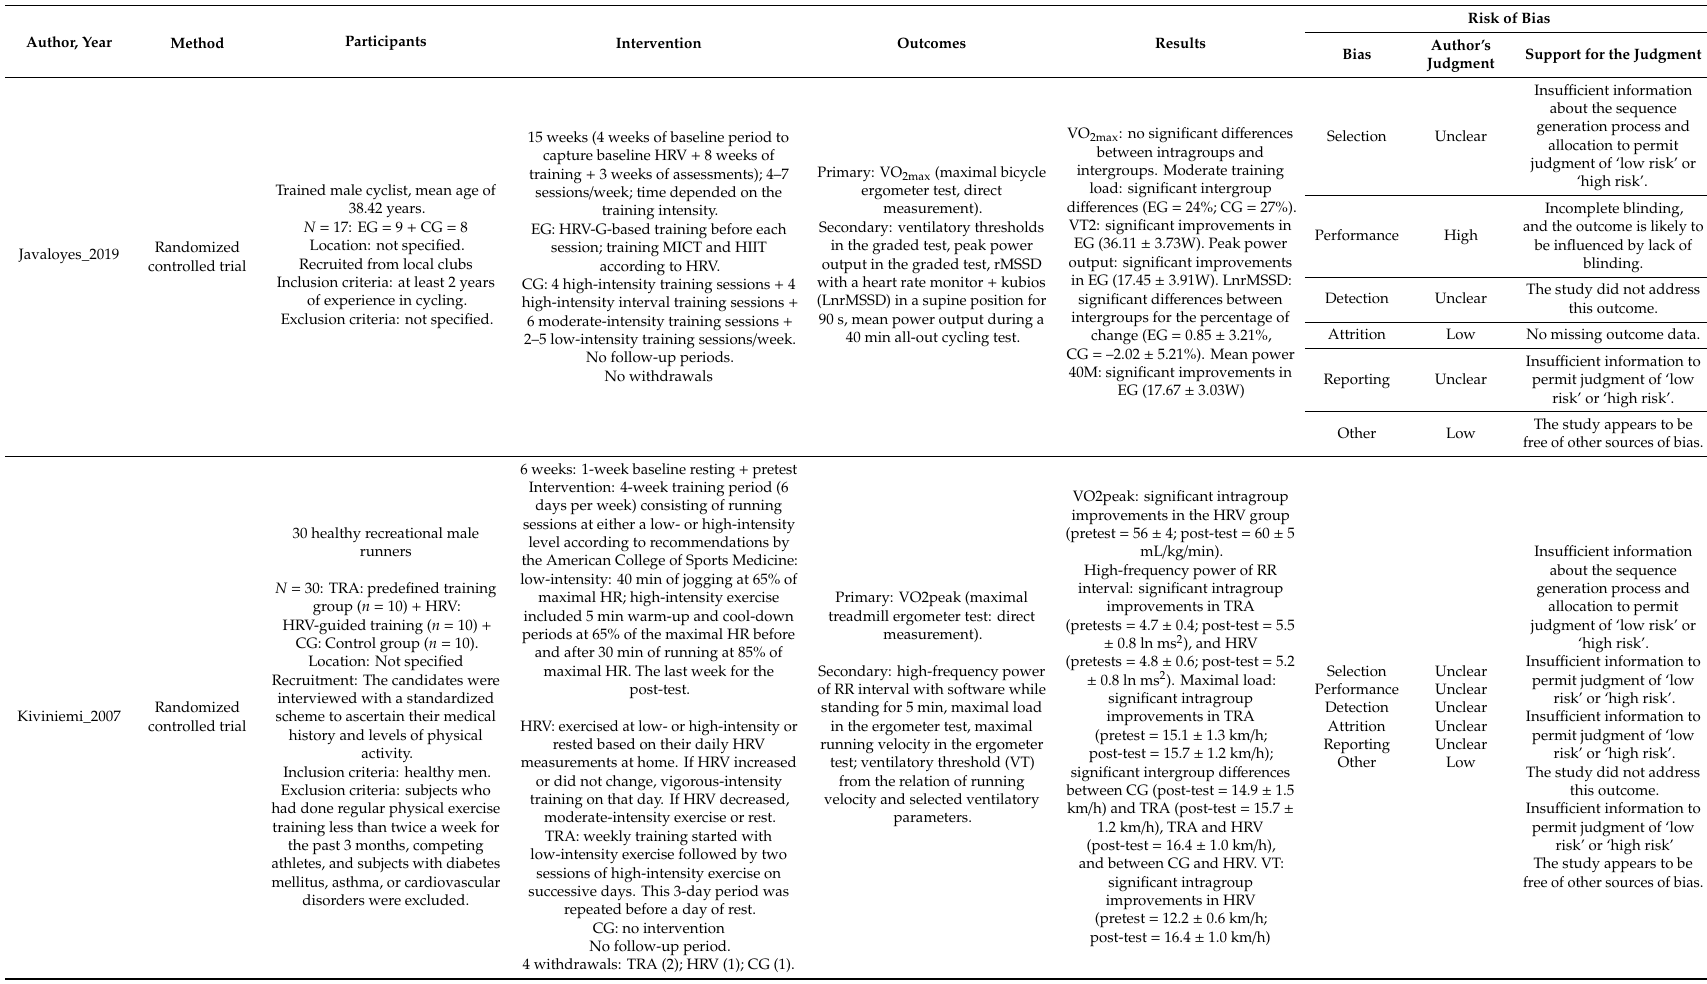
Table 1. Overview of the studies included in the